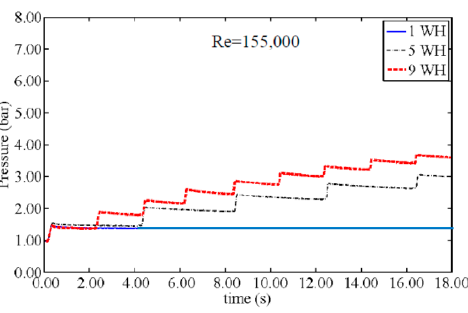
Figure 6. Pressure change in the AP for various WH events and Re for the VFR = 63.35%.